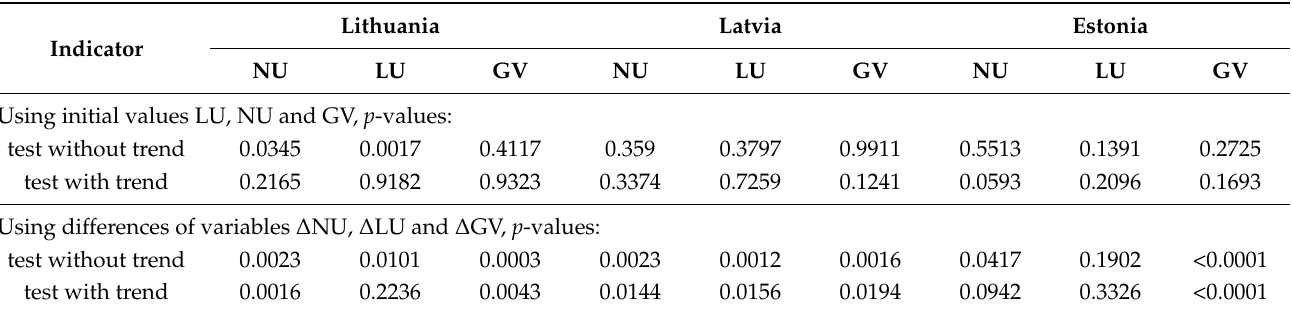
Table 2. Augmented Dickey–Fuller test results.